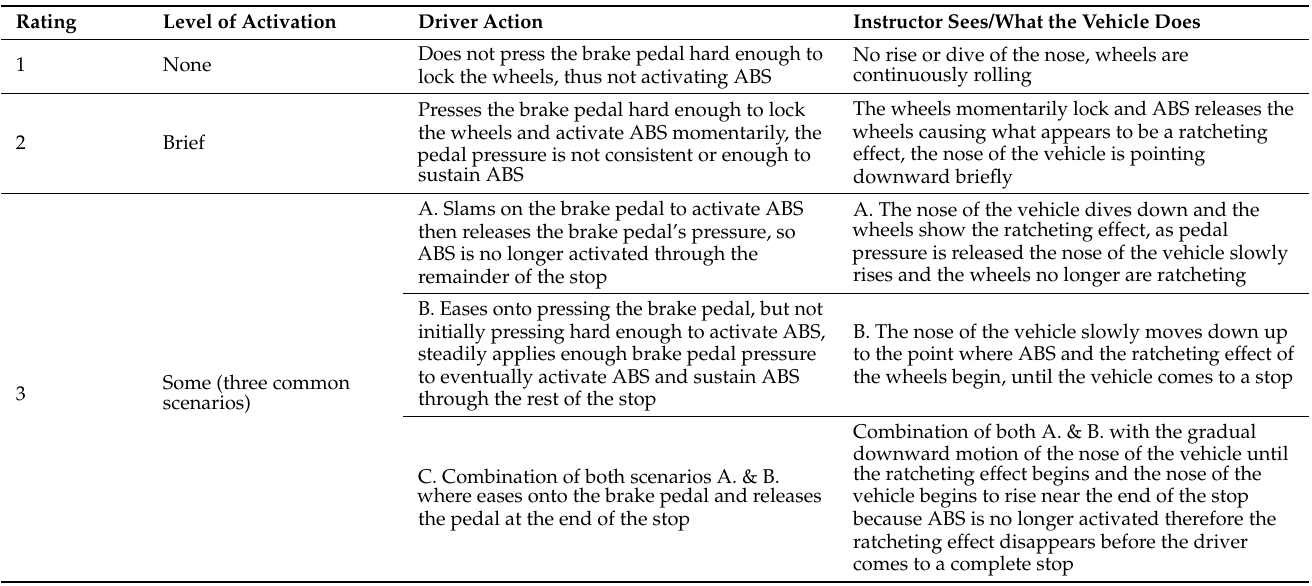
Table 2. Description of each rating including what action the driver took and what the vehicle does or what the instructor sees.